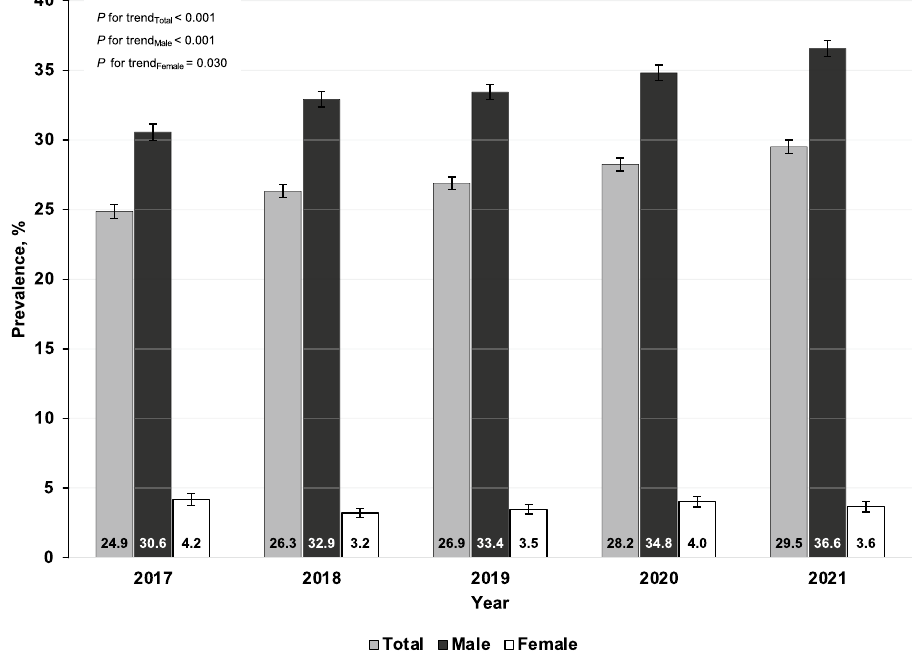
Figure 4. Age-adjusted prevalence (%) of the intermediate-to-high predicted 10-year risk for cardiovascular diseases (CVD) among Royal Thai Army personnel stratified by sex from 2017 to 2021.